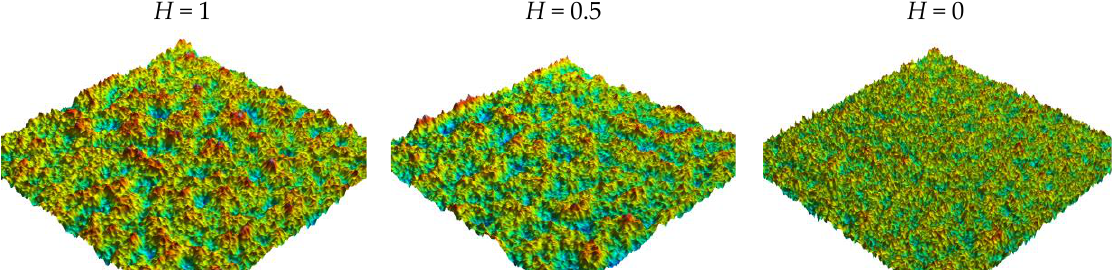
Figure 1. Simulated surfaces (1024 × 1024) following Weierstrass distribution with three different Hurst exponents (1, ½ , 0) from left to right.